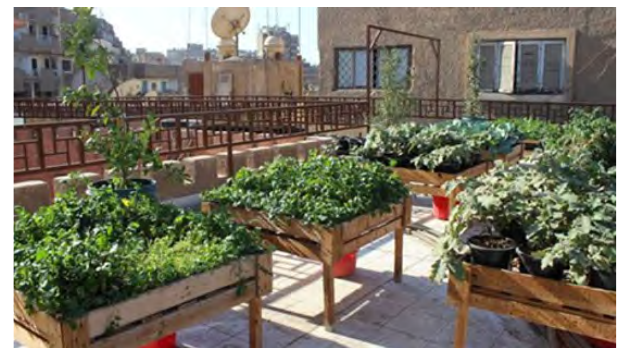
Figure 6. (FAO Regional Office for Near East and North Africa,